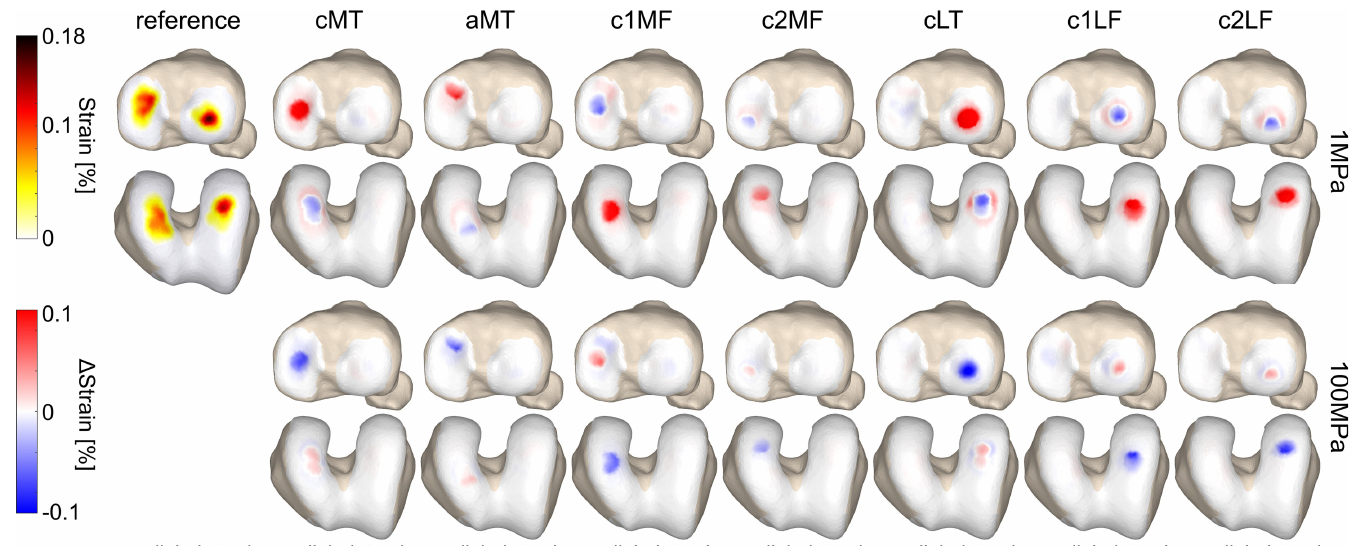
Fig 5. The effect of defect location on the local strain distribution in the tibiofemoral joint. The average strain distribution of a representative sample throughout the stance phase of gait is shown, as well as the difference pattern between defect locations (columns) with an elastic modulus of 1MPa and 100MPa (rows) and the reference simulation. Only defect locations that presented significant differences in the average contact area and pressure at compartment level (Fig 1 and Fig 3) are displayed. Red indicates higher strain compared to the reference simulation, blue indicates lower strain compared to the reference simulation.